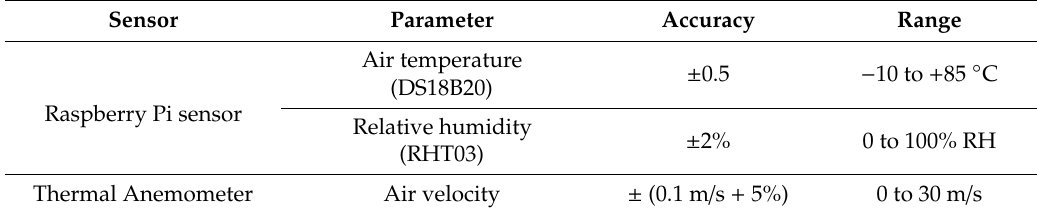
Table 4. Demographics of surveyed